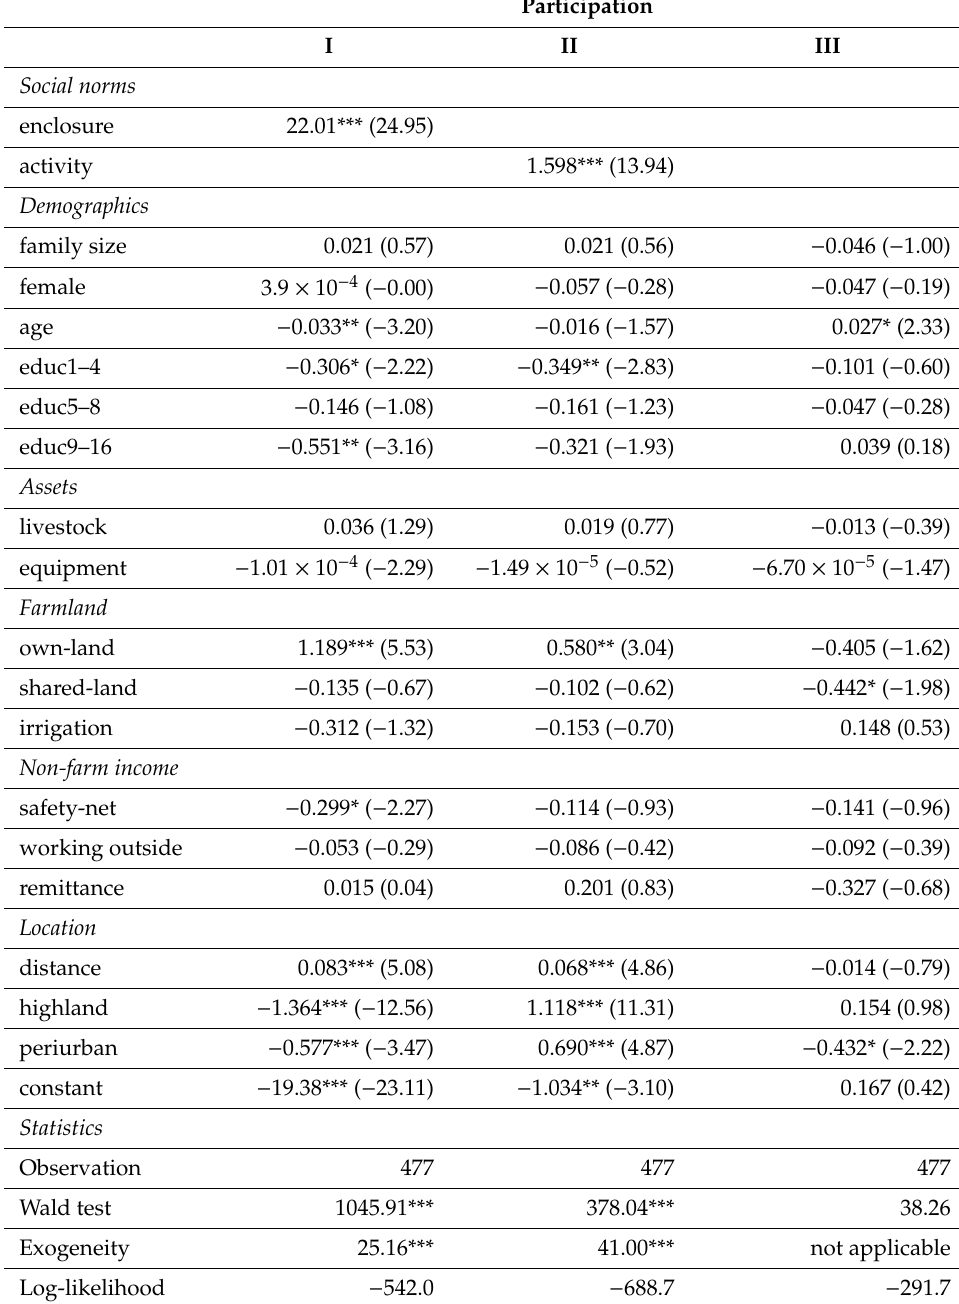
Table 3. Determinants of participation in the hillside distribution project: coe ffi cient estimates of the probit models with endogenous